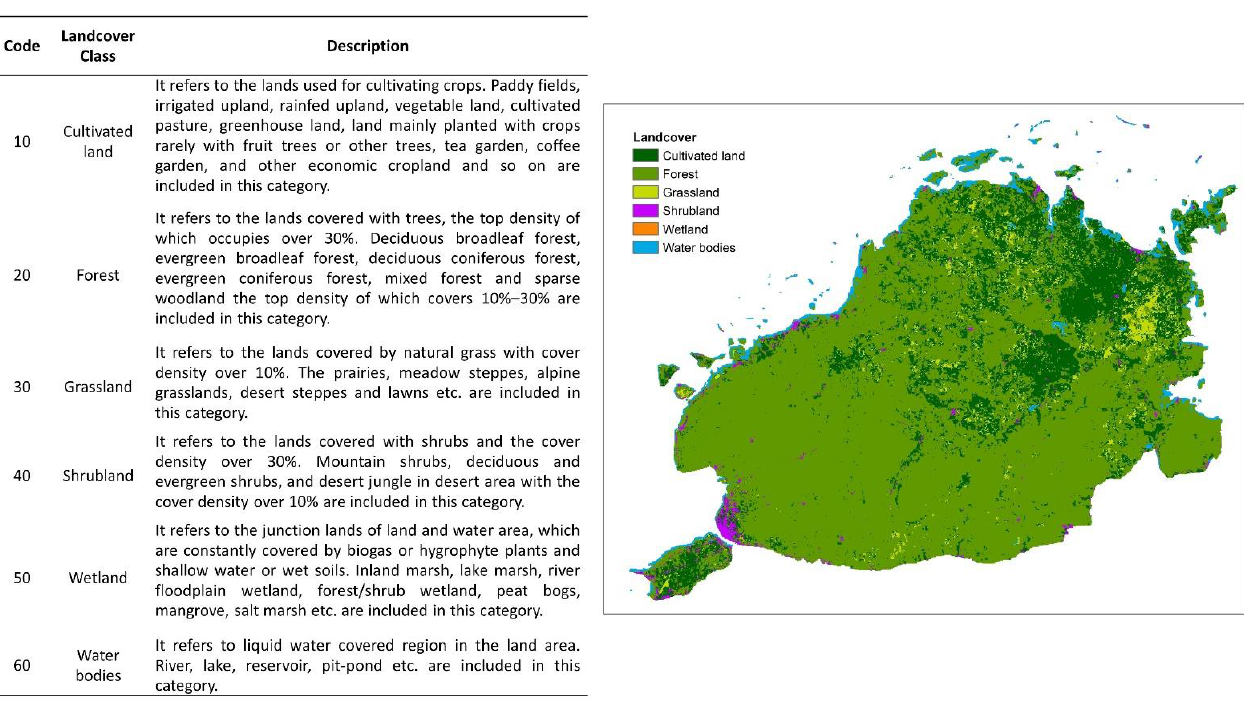
Figure A2. A digital elevation dataset of the study area.